Question: Describe this figure in one sentence.
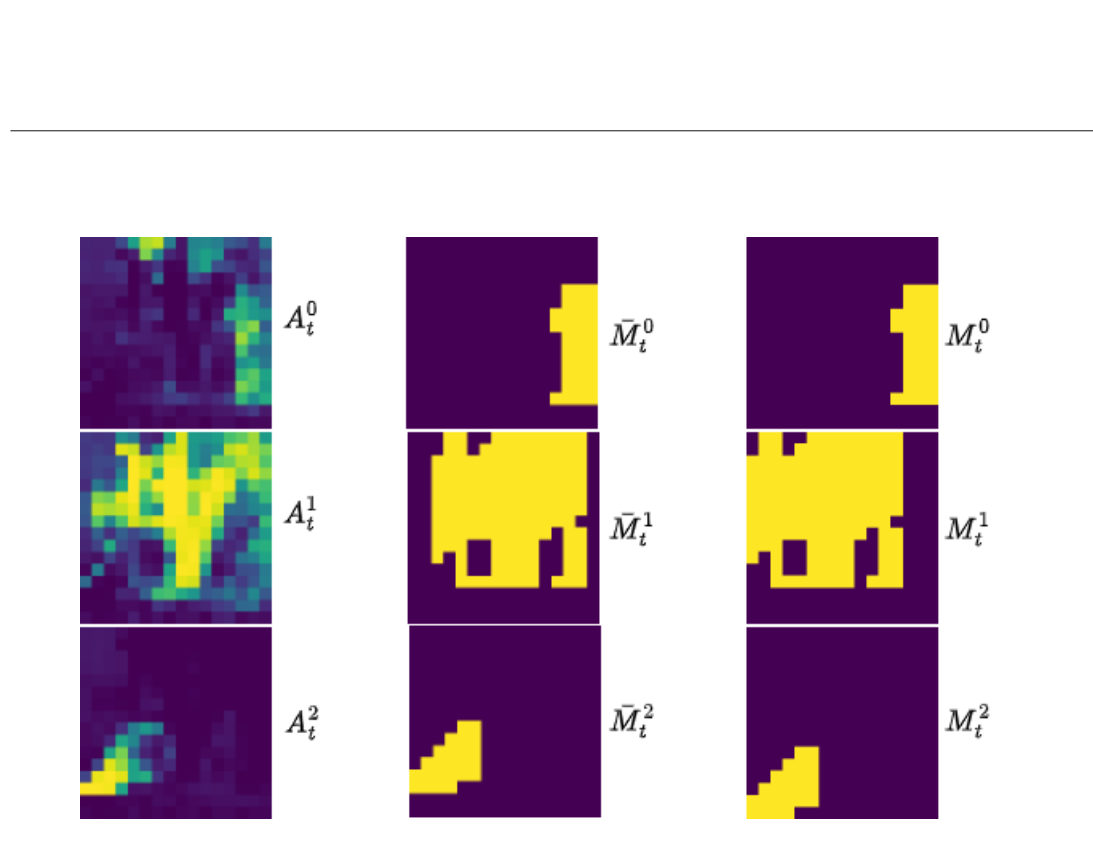
Answer: This figure illustrates Phase2 of the process. On the left, three masks represent the three subjects. In the middle column, we observe the initial masks, which estimate the patches in the attention maps contributing to each subject. On the right, we observe the final masks, after they have been shifted to their new locations. These final masks will subsequently guide the shifting of attention maps As t towards their new location.